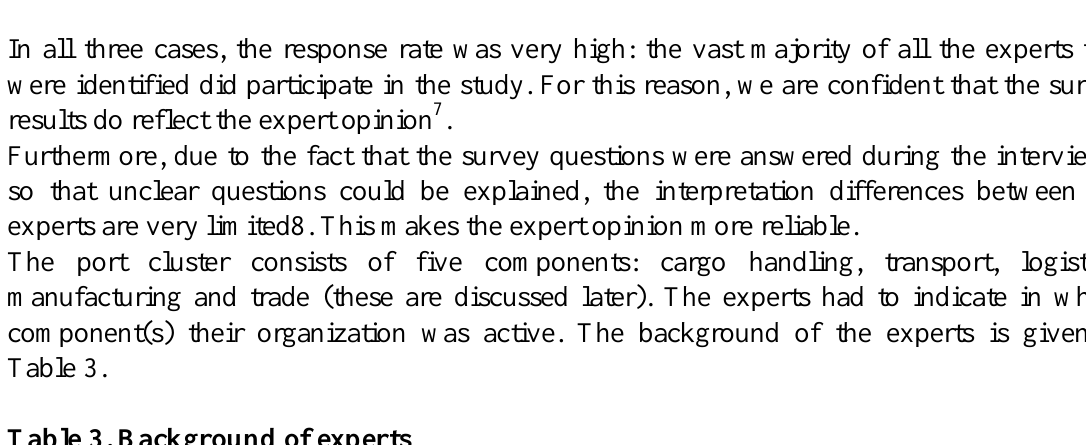
Table 3. Background of